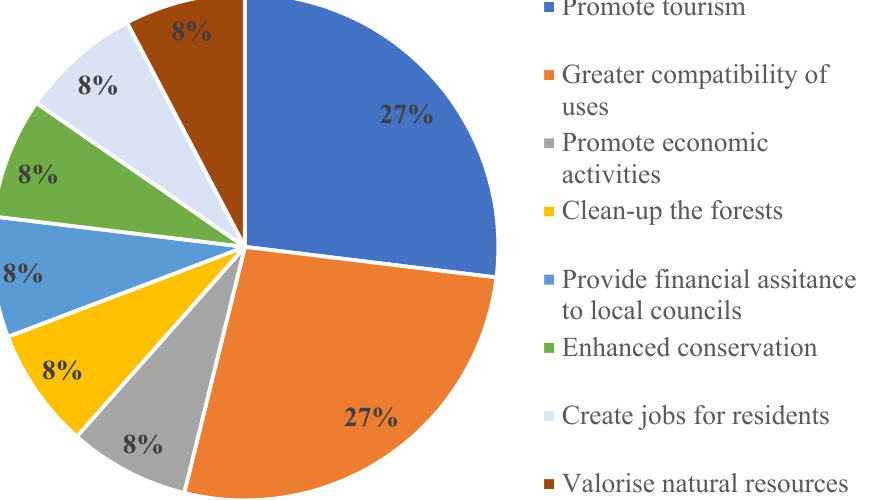
Figure 8. Residents’ actions to improve depopulation figures in protected municipalities to be im- plemented by protected areas’ administrations.